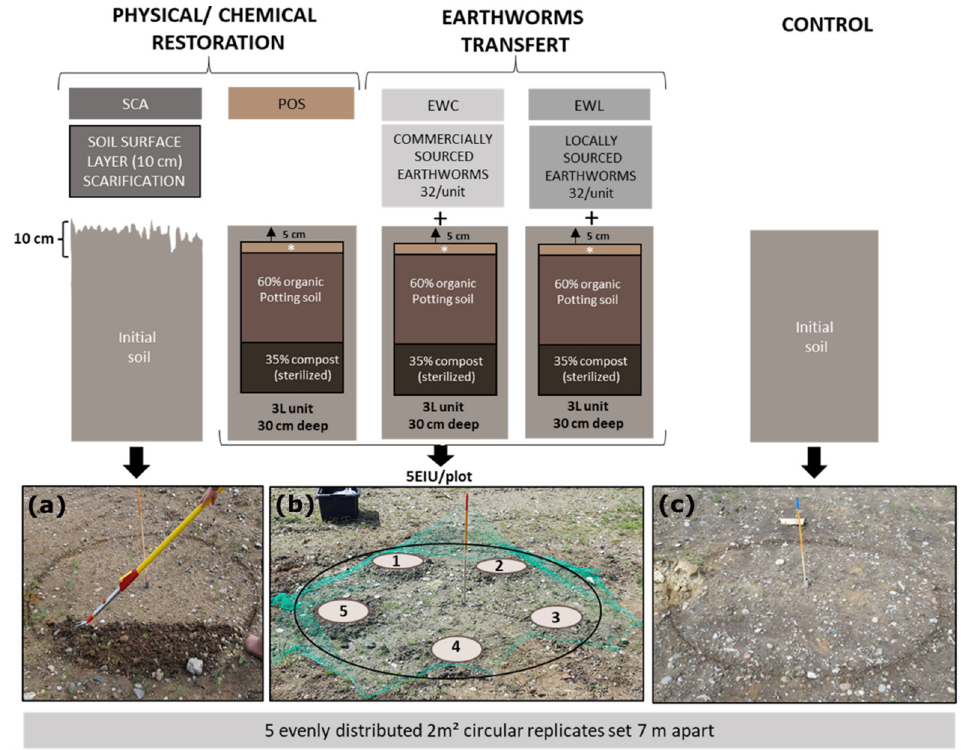
Figure 3. Description of the tested soil restoration techniques. Mechanical soil surface (10 cm deep) scarification (SCA, photo ( a )). Earthworm inoculation techniques consist of the inoculation in the 2m² plot of 5 earthworm inoculation units (EIU; pinked number 1–5 circles) technique each containing 32 commercially sourced earthworms (EWC), 32 locally sourced earthworms (EWL), or no earthworms (POS). Labels 1–5: equidistant location of the five EIU in the replicate protected from birds by a net ( b ). Control (CTL) corresponds to plot where no techniques were applied ( c ). Photo G. Jacek, 2019.